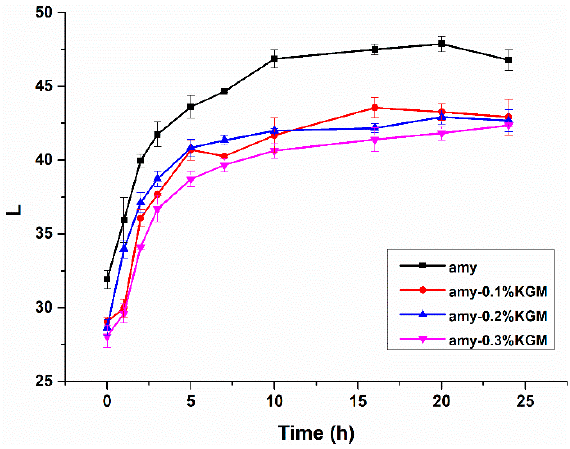
Figure 1. Curves of L values of amylose–KGM mixtures with time.